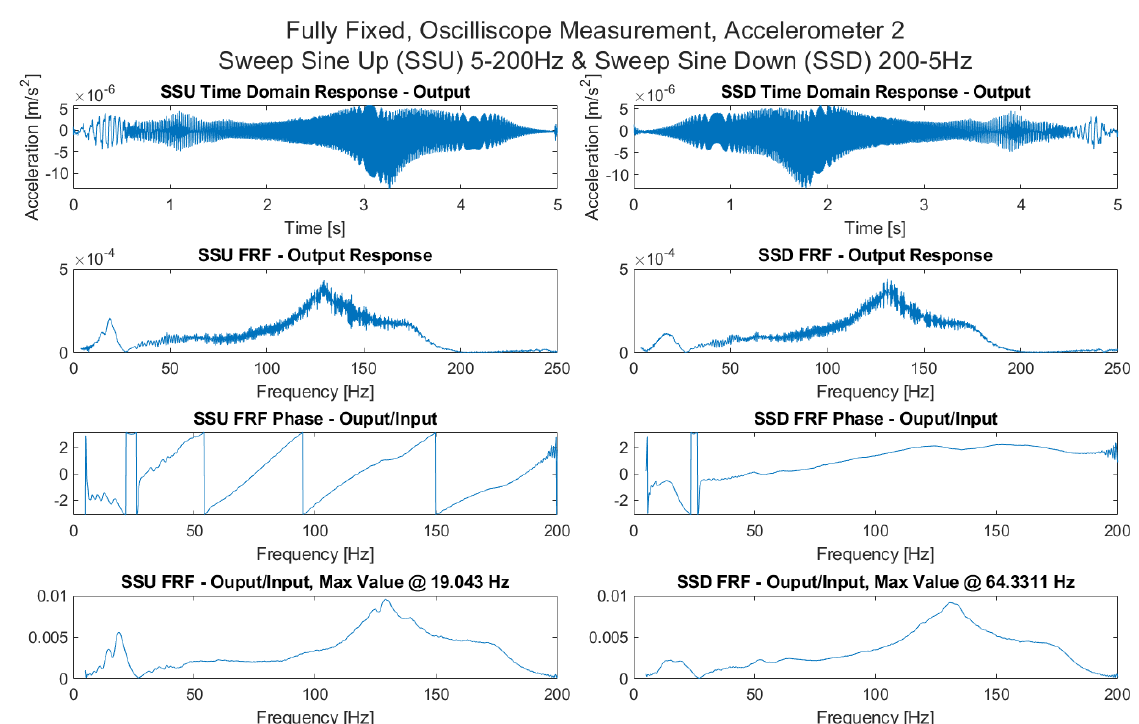
Figure A16 . Swept sine inputs: Oscilloscope measurements: Accelerometer 1 .